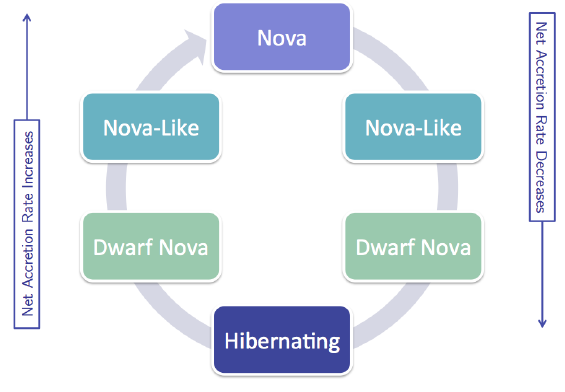
Figure 4: The expected cycle of a CV both pre-and post-nova eruption according to the hibernation